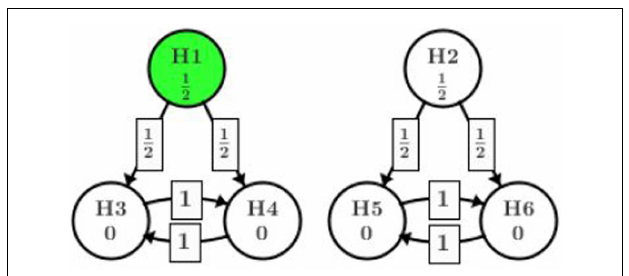
FIGURE 2 | Gatekeeping procedure .